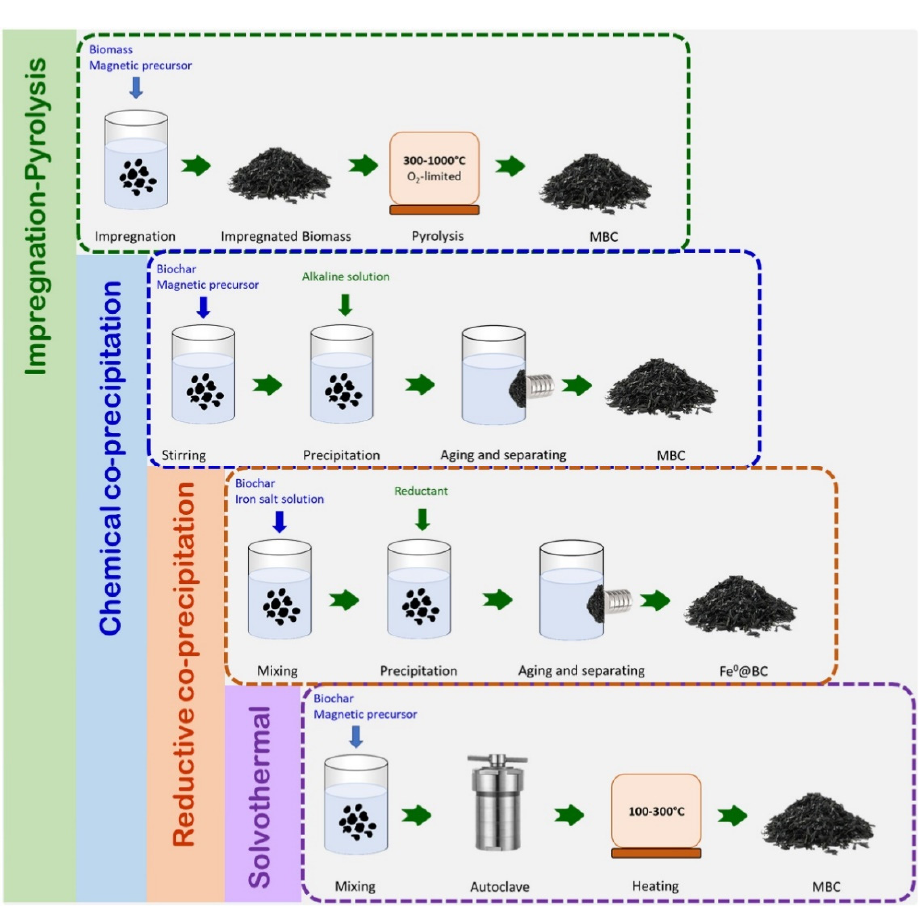
Figure 6. Brief schematic of different magnetic biochar preparation. Reprinted with permission from [32]. Table 2. Surface-modified biochar and its nanocomposites for dye removal from